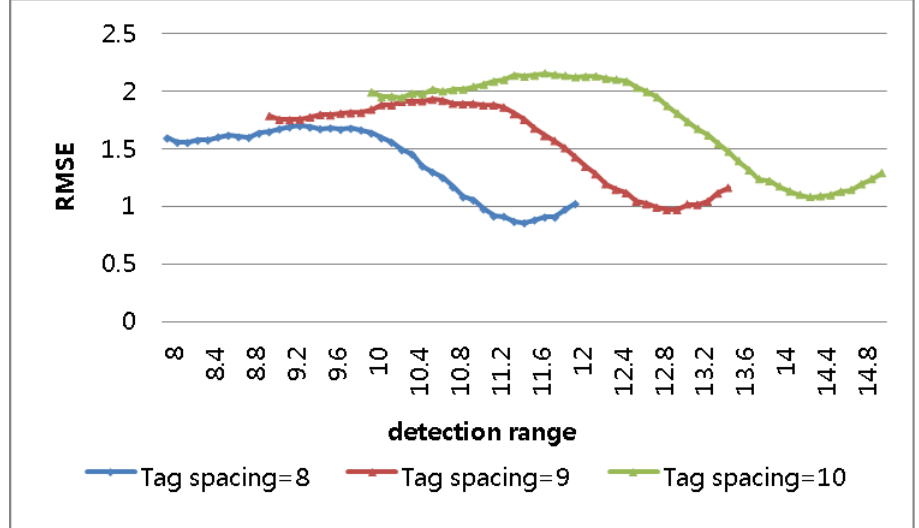
Figure 14. RMSE for detection ranges varying to 150% in 3-dimensional-space numerical approach.